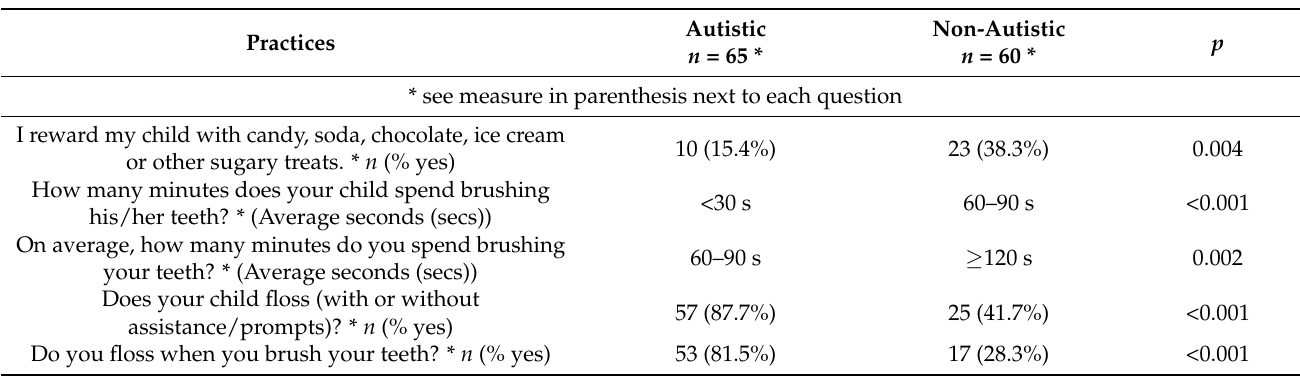
Table 4. Significant Differences in Individual Items of Oral Care Practices Families with Autistic Children and Children Without